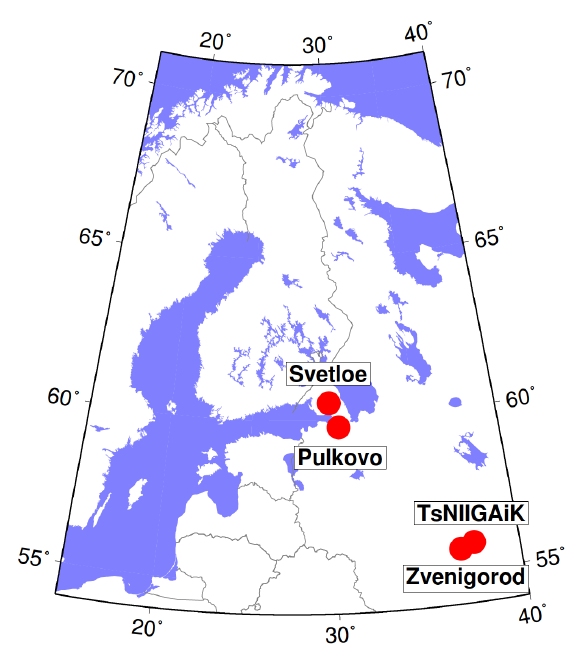
Figure 1: Location of the comparison